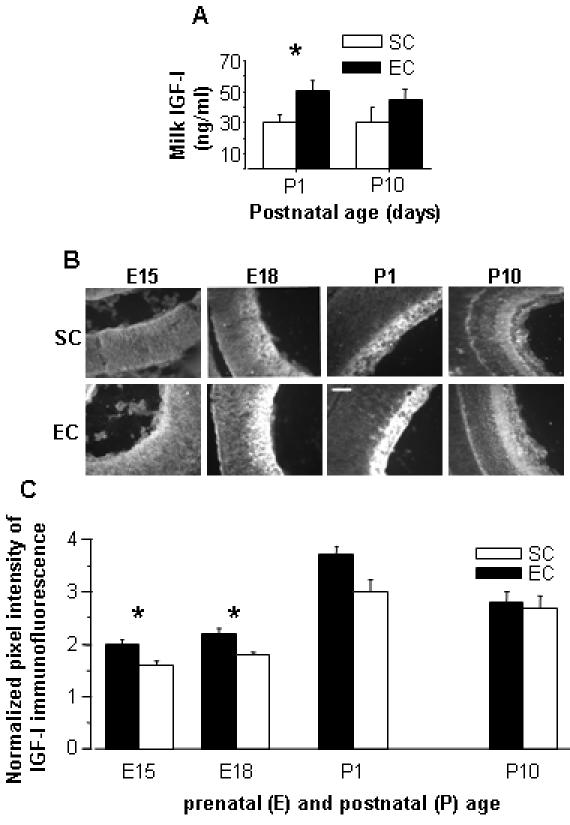
(A) Increased IGF-I concentration in the maternal milk.RIA determination of IGF-I concentration in the milk of SC and EC suckling pups: two-ways ANOVA showed a significant age×housing condition interaction (p<0.05). Post-hoc Tukey test revealed a difference at P1 (p<0.05), but not at P10 (p = 0.258) between EC and SC groups. Bars indicate s.e.m. (B–C) Enhanced IGF-I expression in the RGC layer of EC rats. (B) Micrographs of EC and SC retinal sections immunostained for IGF-I at different ages. Scale bar: 50 µm (C) Quantitative analysis of IGF-I immunofluorescence intensity in the RGC layer of SC and EC rats. Two-ways ANOVA showed an effect of age (p<0.001) and housing condition (p<0.001). t-test with Bonferroni correction revealed a statistical difference between EC and SC groups at E15 (p = 0.009) and E18 (p<0.01).